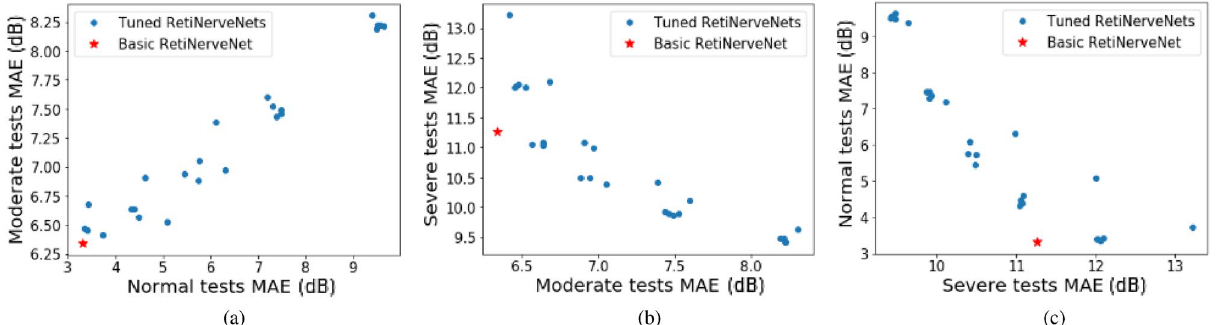
Figure 4. Trade-off among the performances on the early/no, moderate, and advanced disease MD groups of tests: The performance on the advanced disease group improves when we assign higher weightage to tests from the underrepresented MD intervals, while the performance on the early/no disease and moderate disease groups worsens. Very little trade-off is observed between the early/no disease and moderate disease groups. The basic RetiNerveNet performs particularly well on the early and moderate disease tests, at the expense of the advanced disease group.